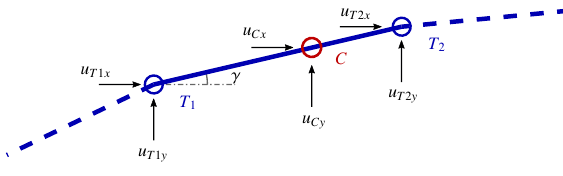
Figure 2. Master element and slave